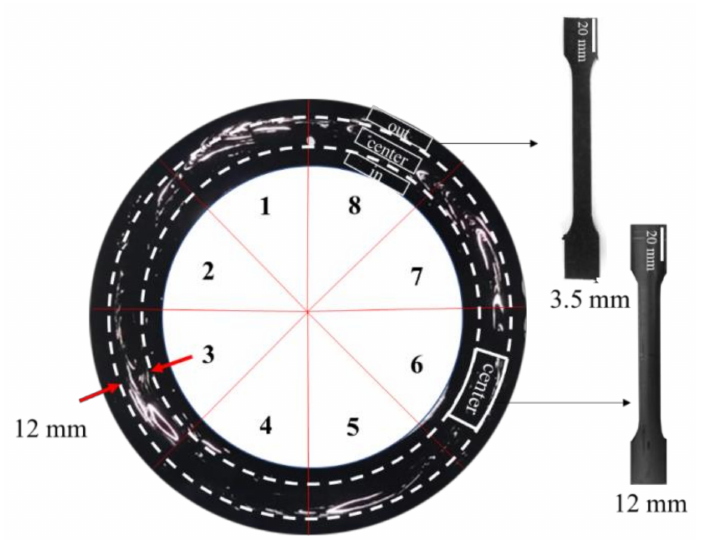
Figure 3. Eight sectors with known % windows where 12 mm thick tensile specimens were taken. The 3.5 mm thick specimen locations are also shown.